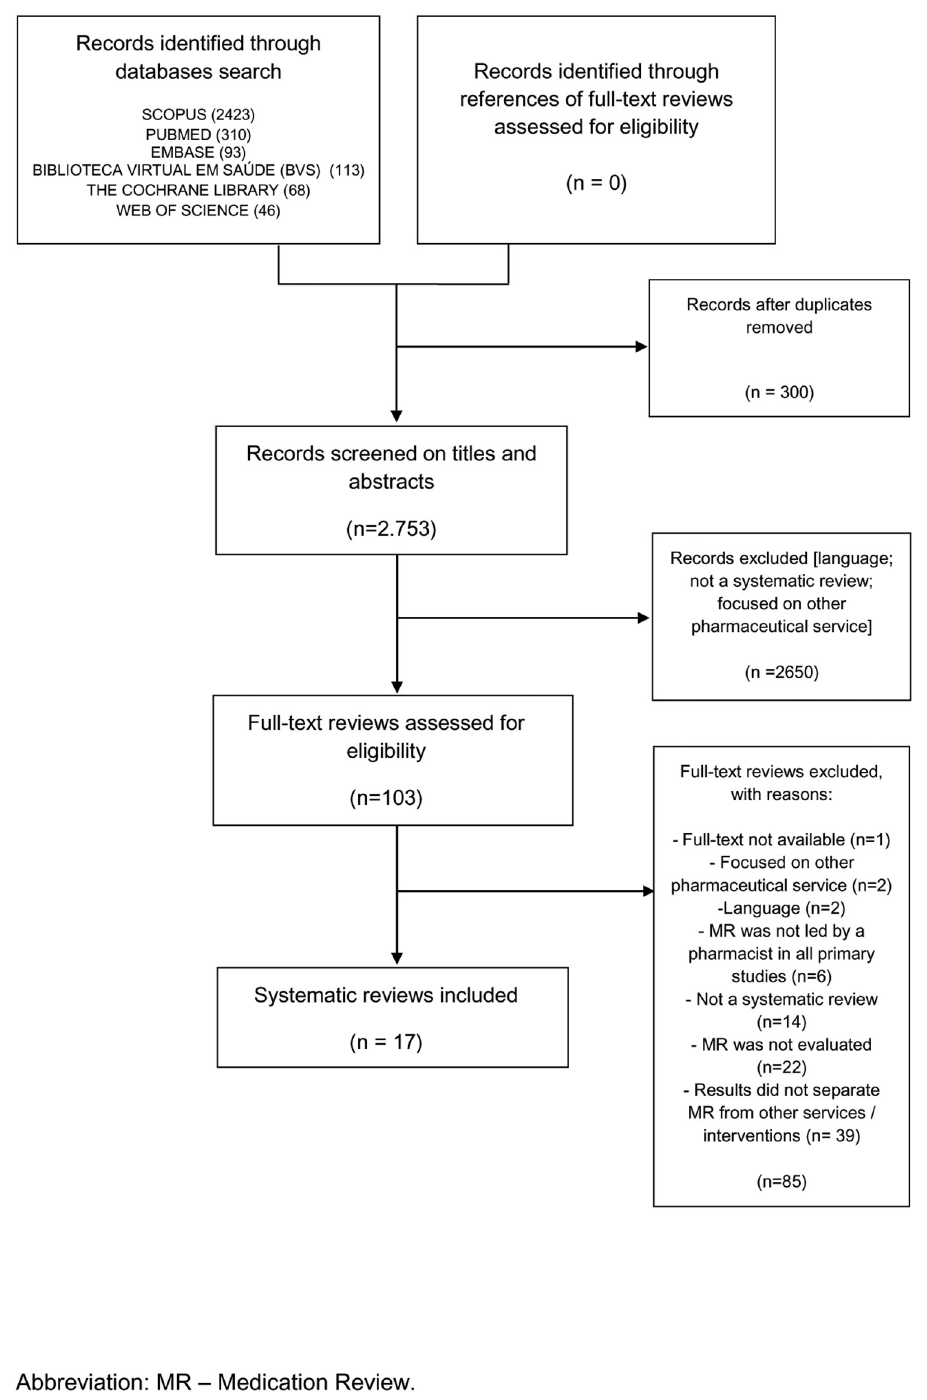
Fig 1. Flowchart of systematic reviews included in this